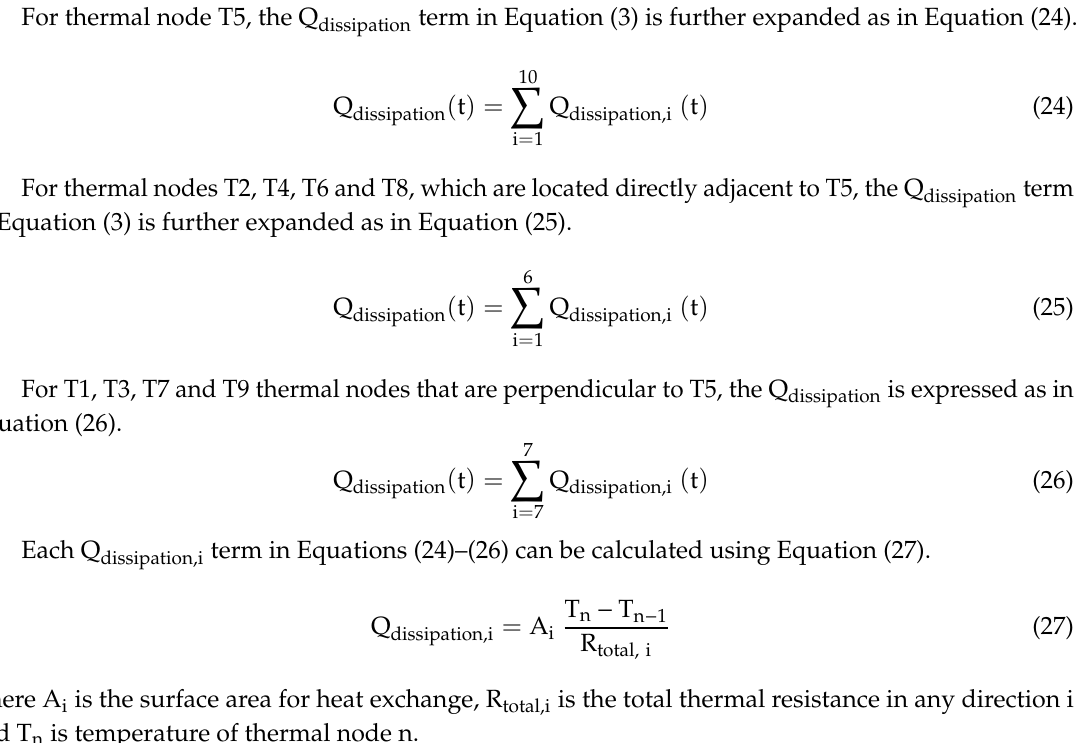
Figure 1. Thermal resistance network for heat transfer modelling.